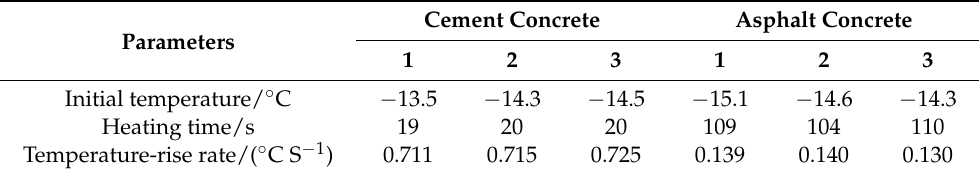
Table 9. Deicing efficiency of concrete with different pavement materials at 5.8 GHz frequency. Parameters